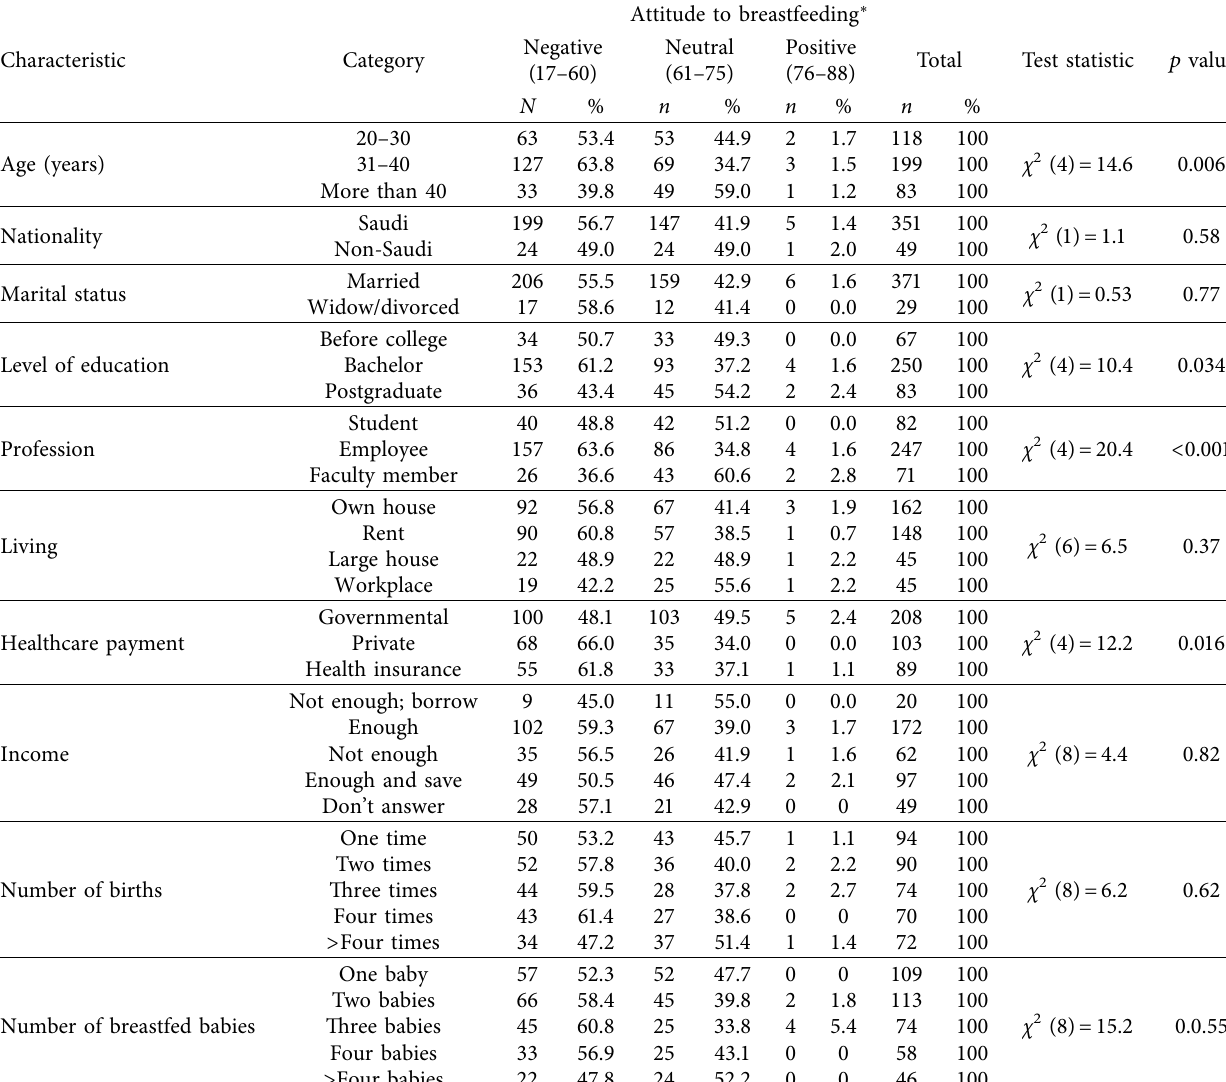
Table 5: Distribution of breastfeeding attitude by sociodemographic characteristics: age, nationality, marital status, education, profession, living, payment, and